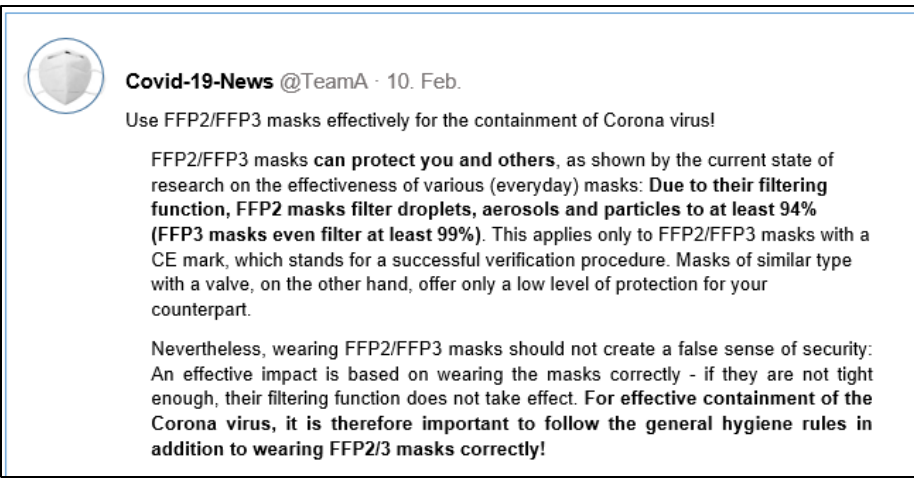
Figure A1. Scientific Posting Team A. Note. Predictor media content: scientific Posting Team A. Originally presented in German. Translation: “FFP2/FFP3-Masken effektiv für die Eindämmung des